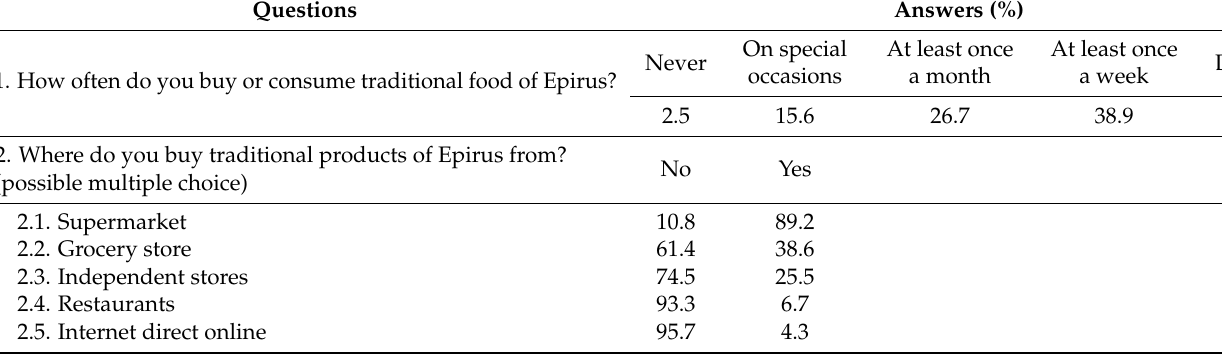
Table 7. Participants’ access to Epirus’